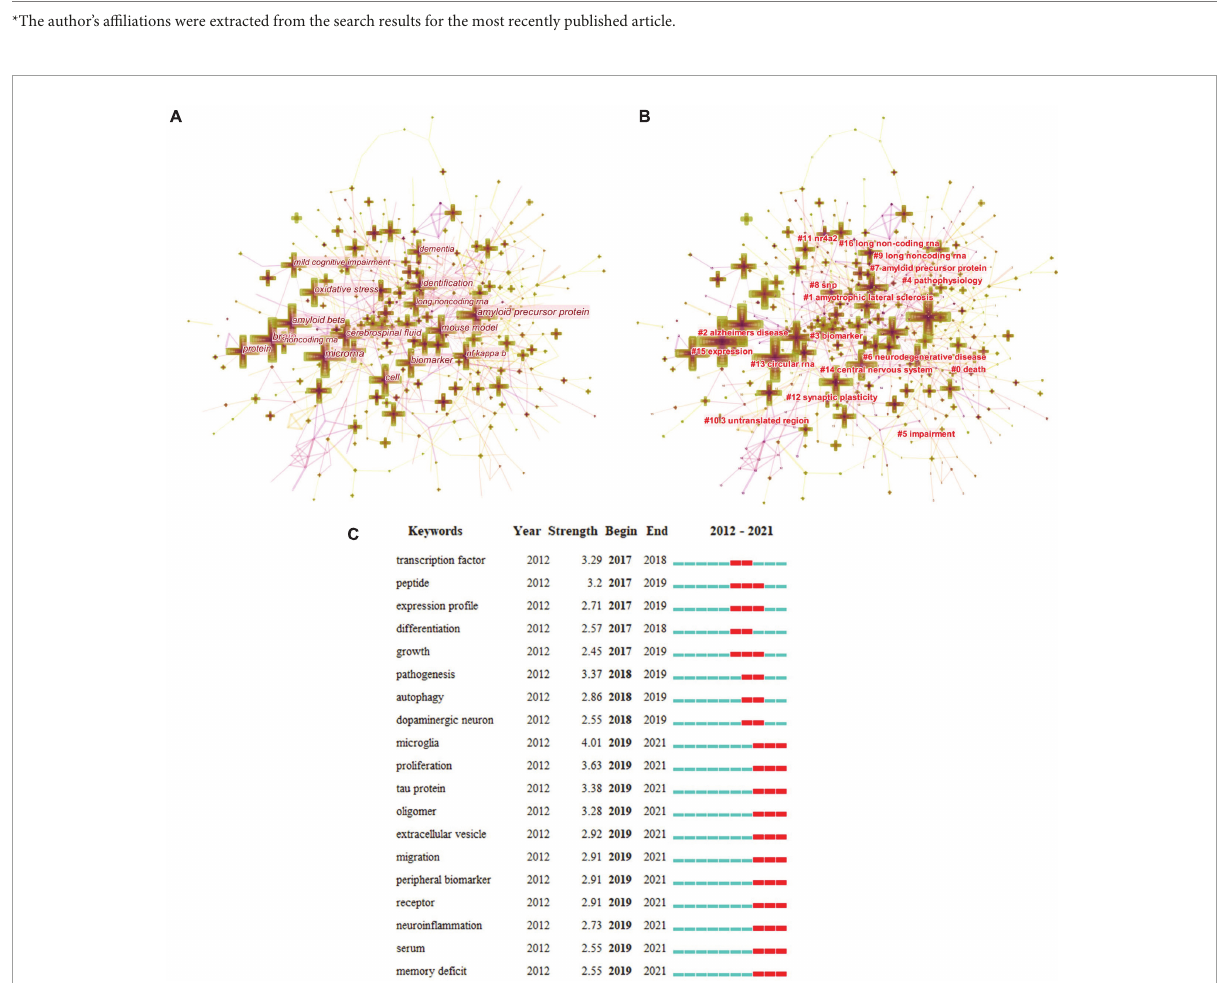
Frontiers in Aging